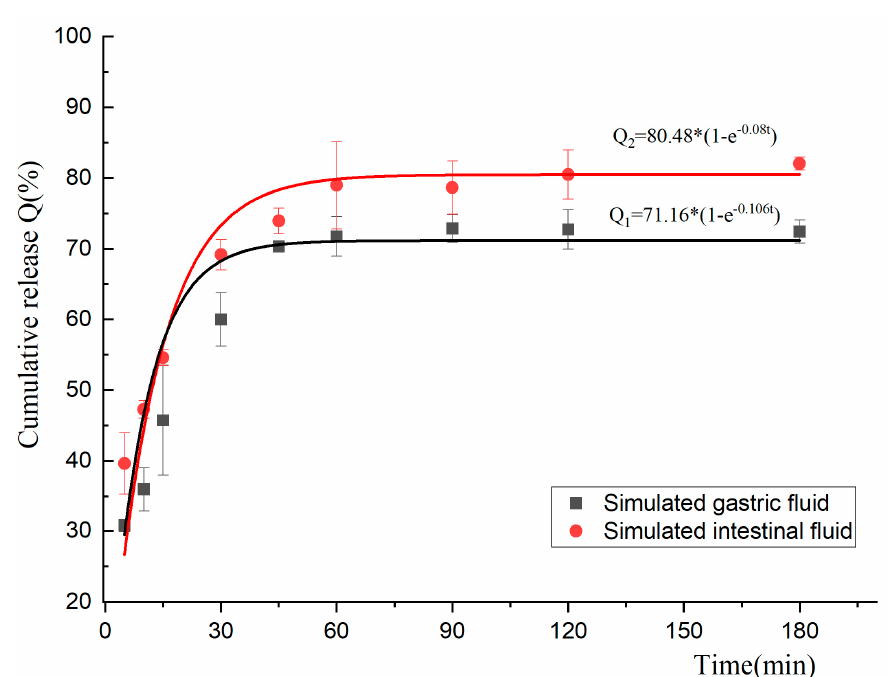
Figure 5. Fitting results of first-order release model of BEO microcapsules in SGF and SIF.